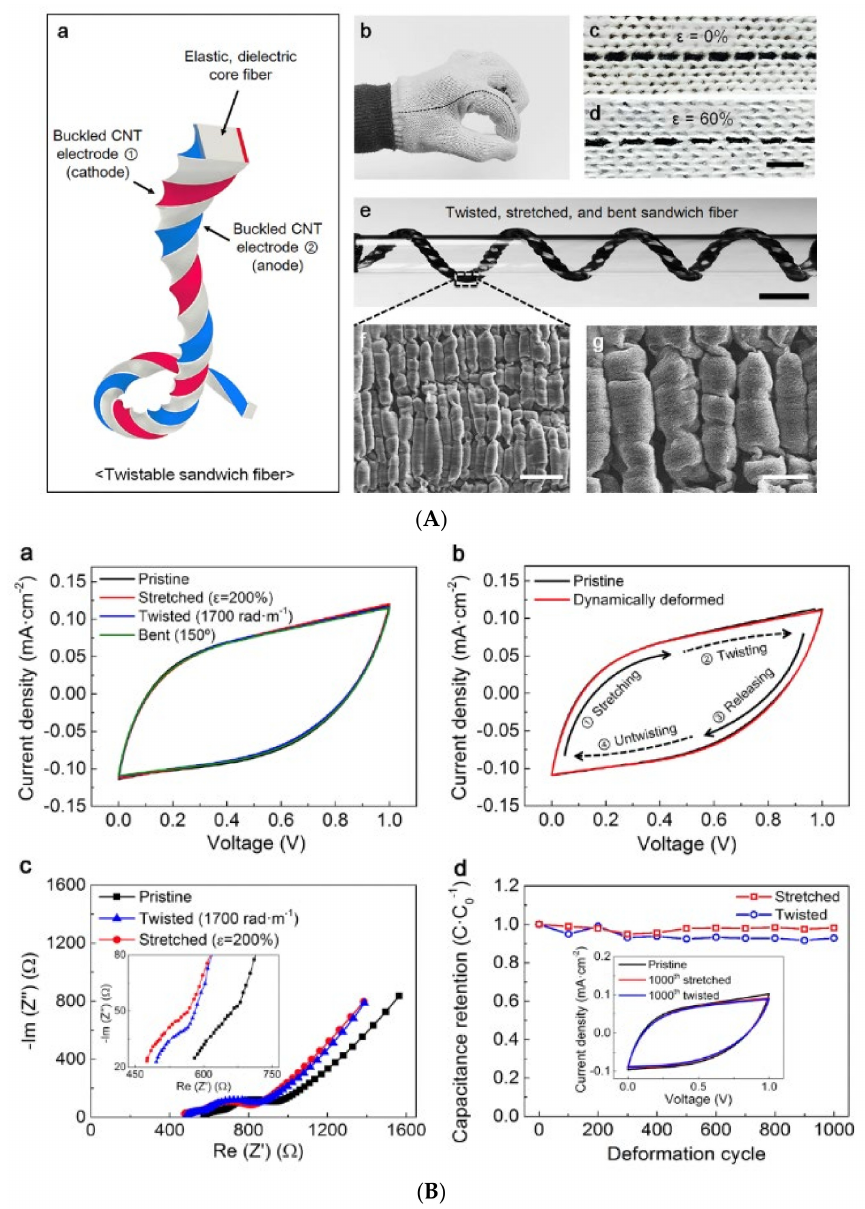
Figure 21. ( A ): ( a ) Twistable and stretchable sandwich fiber with dielectric Ecoflex 0040 rubber core and two symmetric buckled CNT electrodes. ( b ) Photograph of a 20 cm long sandwich fiber integrated into a glove. ( c ) SEM images, unstrained and ( d ) strained (60%) (scale bar: 8 mm); ( e ) photograph of the sandwich fiber wound around a 7mm diameter glass tube (scale bar: 50 mm), with SEM images showing microscopic CNT buckles at two levels of magnification, ( f ) low